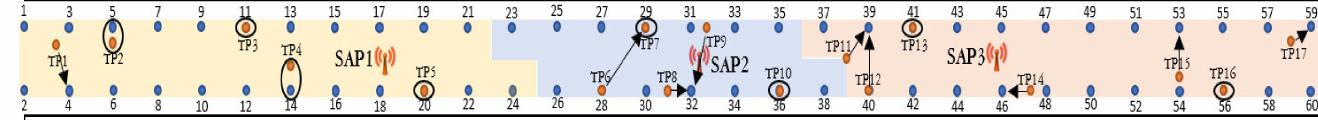
Figure 9. Determined user location of the proposed method. The blue dots represent the RPs, and the orange dots represent the TPs. The RPs pointed with an arrow and circle is the determined user